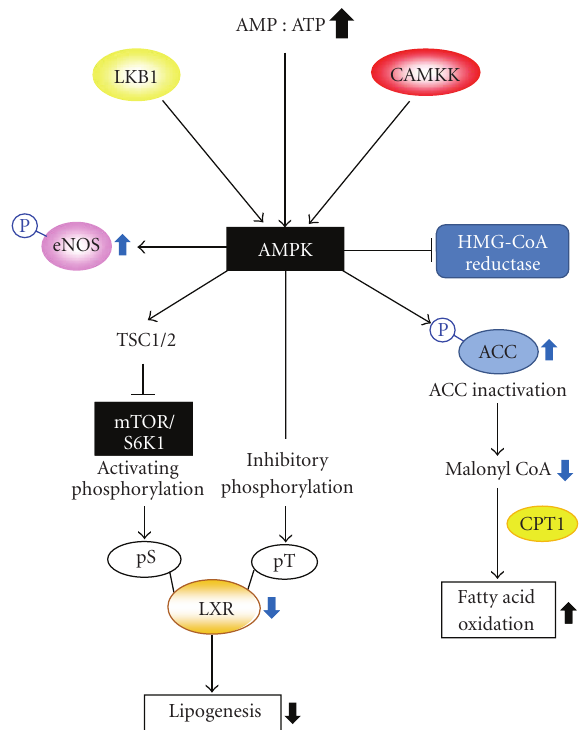
Figure 2: The regulatory role of AMPK in metabolic functions. CAMKK: CaM-dependent protein kinase kinase; eNOS: endothelial nitrogen oxide synthase; TSC1/2: tuberous sclerosis 1/2; mTOR: mammalian target of rapamycin; S6K1: p70 ribosomal S6 protein kinas; LXR: liver X receptor; ACC: acetyl-CoA carboxylase; CPT1: carnitine palmitoyltransferase